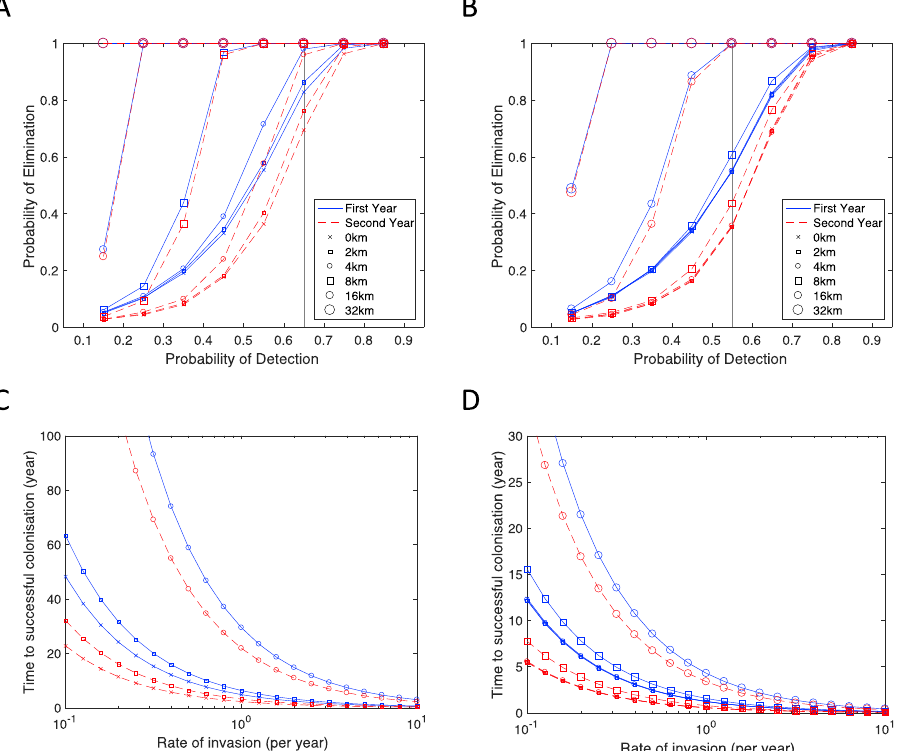
Figure 3. The probability of V. velutina eradication following successive years of nest detection and destruction. All results represent the average over (ten thousand) stochastic replicates and capture full parameter uncertainty. Solid blue lines represent simulations where detection (and destruction) begin in the year of invasion – when there is assumed to be only one active nest; dashed red lines correspond to simulations where the invading nest remained undiscovered in the first year, and probabilistic detection only begins in the second year. Crosses are for simulations without additional radial detection, while open symbols represent differing radii of detection. In ( A ) we assume that once a nest is probabilistically detected a thorough search of the area will find 99% of all nests within a given radius; in ( B ) we assume these radial searches only find 48% of nests (comparable to the detection probability in Andernos-les-Bains (Supplementary Material)). In ( C ) and ( D ) we investigate the expected time to successful colonisation when the UK is subjected to a constant rate of invasion; detection rates in ( C ) and ( D ) correspond to the vertical lines in ( A ) and ( B ). Search radii of 8 km or more in ( C ) and 32 km in ( D ) lead to permanent exclusion of V. velutina